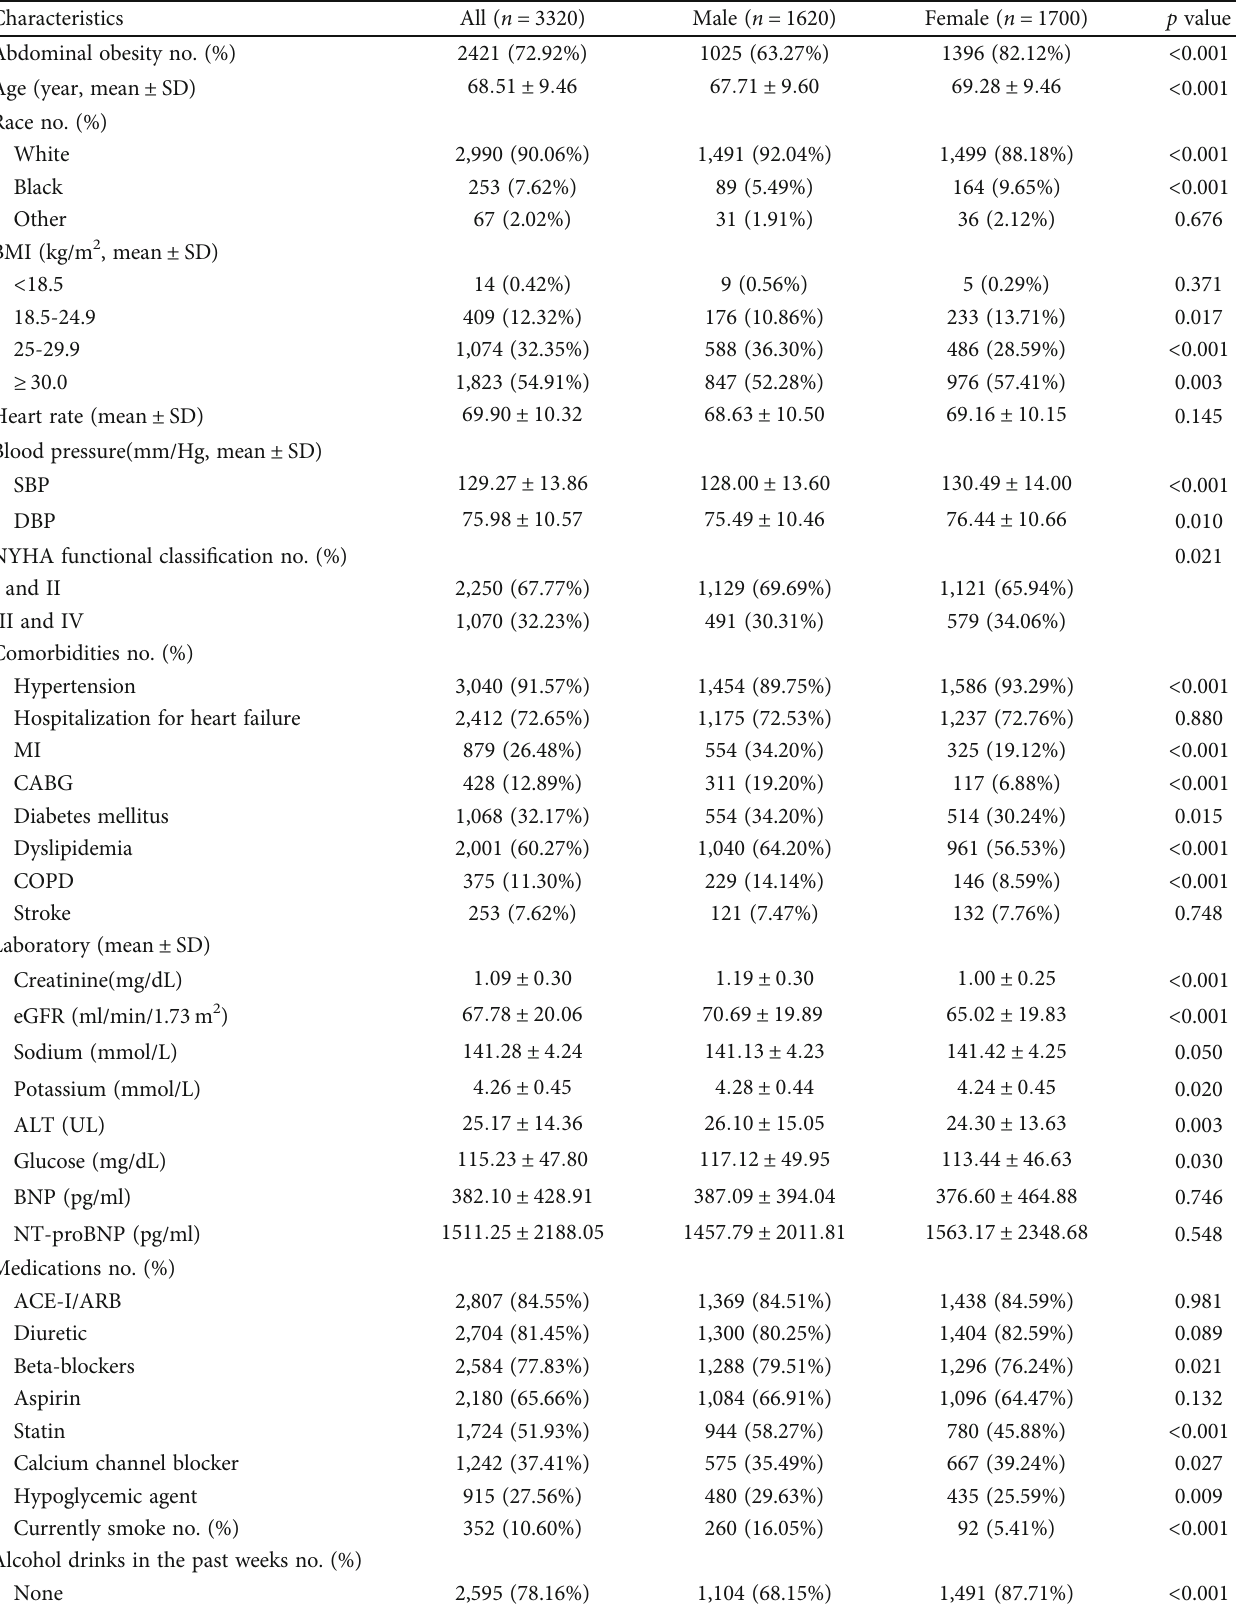
Table 1: Demographic and clinical